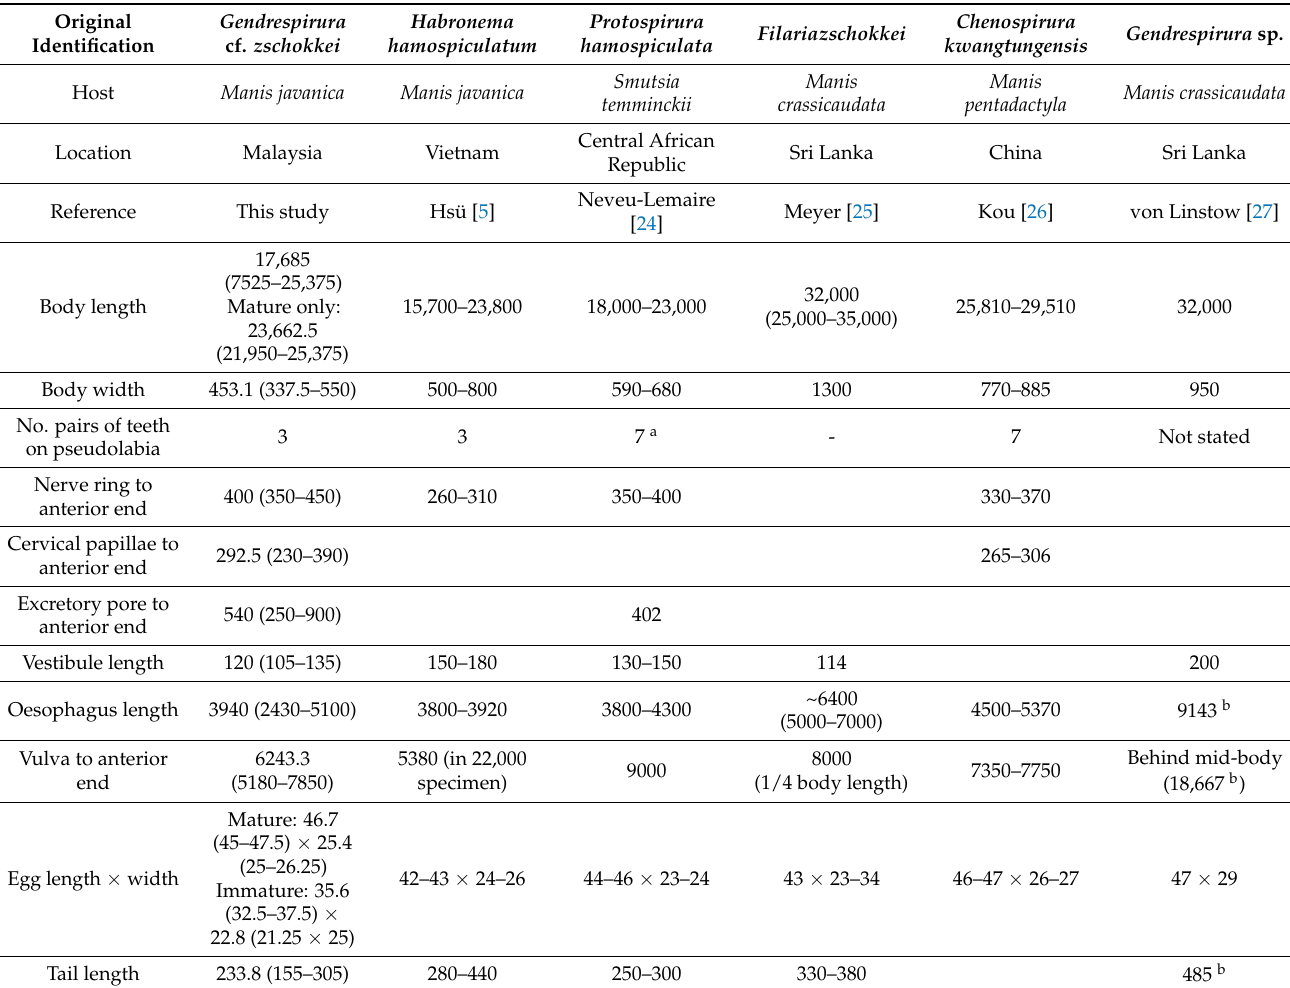
Table 2. Measurements of female Gendrespirura cf. zschokkei collected from Manis javanica in this study compared to previous reports of specimens collected from various pangolins. Species names listed by their original described name; currently all species are considered within Gendrespirura . Measurements are presented in